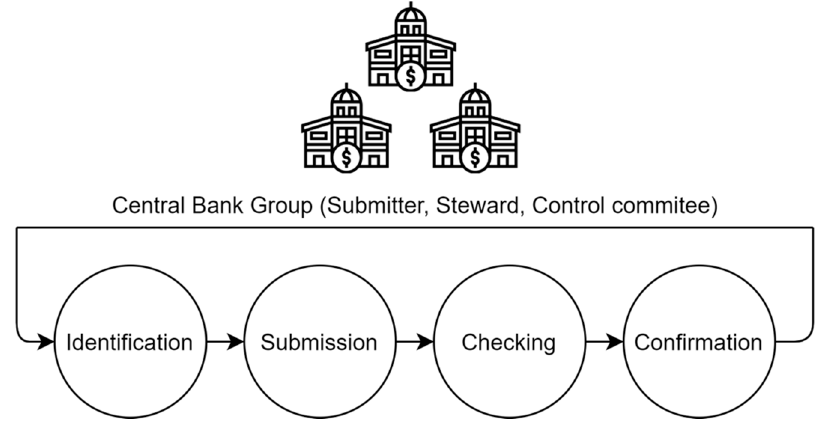
Figure 5. Registration procedure of CBDC.